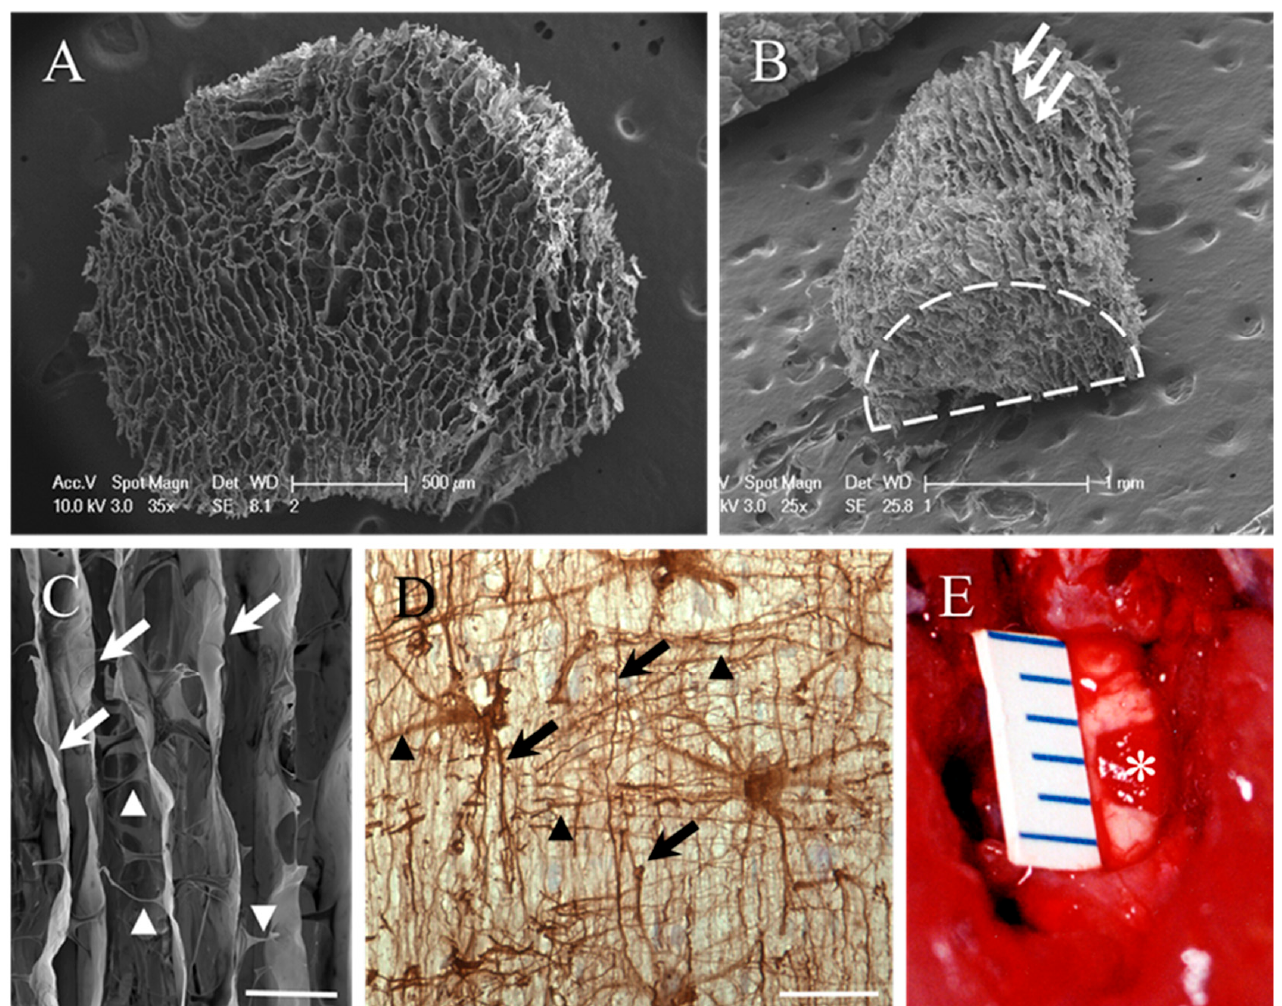
Figure 1. Biomimetic design of the microporous collagen scaffold. ( A ) SEM of the honeycomb-like appearance of the collagen scaffold cylinders after being removed from the 2 mm tissue punch (end- on view). ( B ) Tangential view of the scaffold hemi-cylinder generated by a mid-line incision along the axis of the cylinder. The profile of the end of the hemi-cylinder is highlighted by the dashed line. Longitudinal orientation of the porous framework can be identified on the scaffold surface (white arrows). ( C ) Higher-magnification SEM demonstrating the walls of longitudinally orientated scaffold framework (white arrows). The substantial fenestration between adjacent micropores is highlighted by the transversely orientated profiles (arrowheads). This bioengineered framework mimics, to some extent, the pattern and orientation of the astroglial framework of spinal cord white matter tracts as revealed by immunohistochemistry. ( D ) Glial fibrillary acidic protein (GFAP) immunohistochemistry of the interwoven pattern of longitudinal (black arrows) and transverse (black arrowheads) astrocytic processes in a longitudinal section of the lateral funiculus of the adult rat spinal cord. ( E ) A 2 mm long hemi-cylinder of the collagen scaffold (asterisk) fits neatly into the gap generated by the lateral funiculotomy of the adult rat cervical spinal cord, making excellent implant–host contact. The implant appears red after absorbing blood from the surrounding host tissue. The size of the lesion/implant is indicated by mm scale. Scale bars: A = 500 µm; B = 1 mm; C = 50 µm; D = 50 µm.